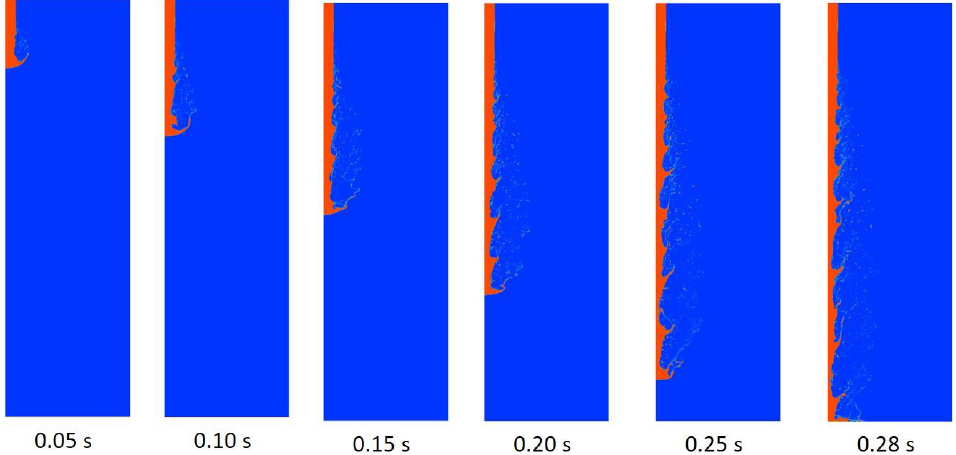
Figure 3. Progression of jet breakup in two-dimensional simulation.